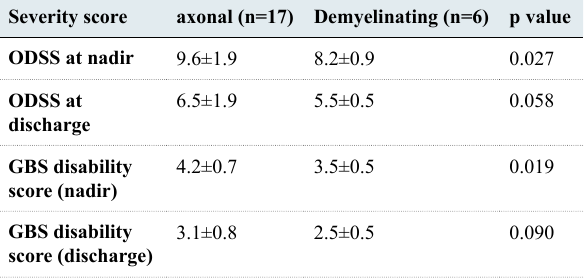
Table 3: Clinical Severity according to ODSS and